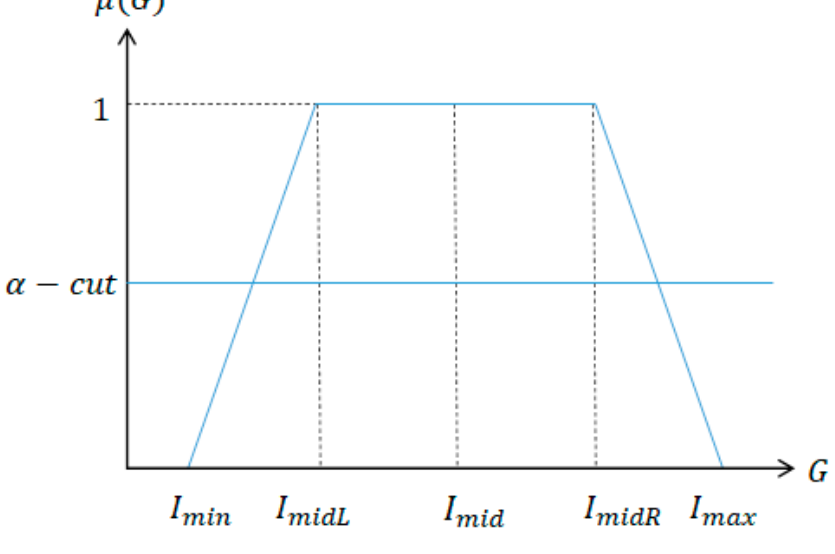
Figure 1. Trapezoidal membership function.